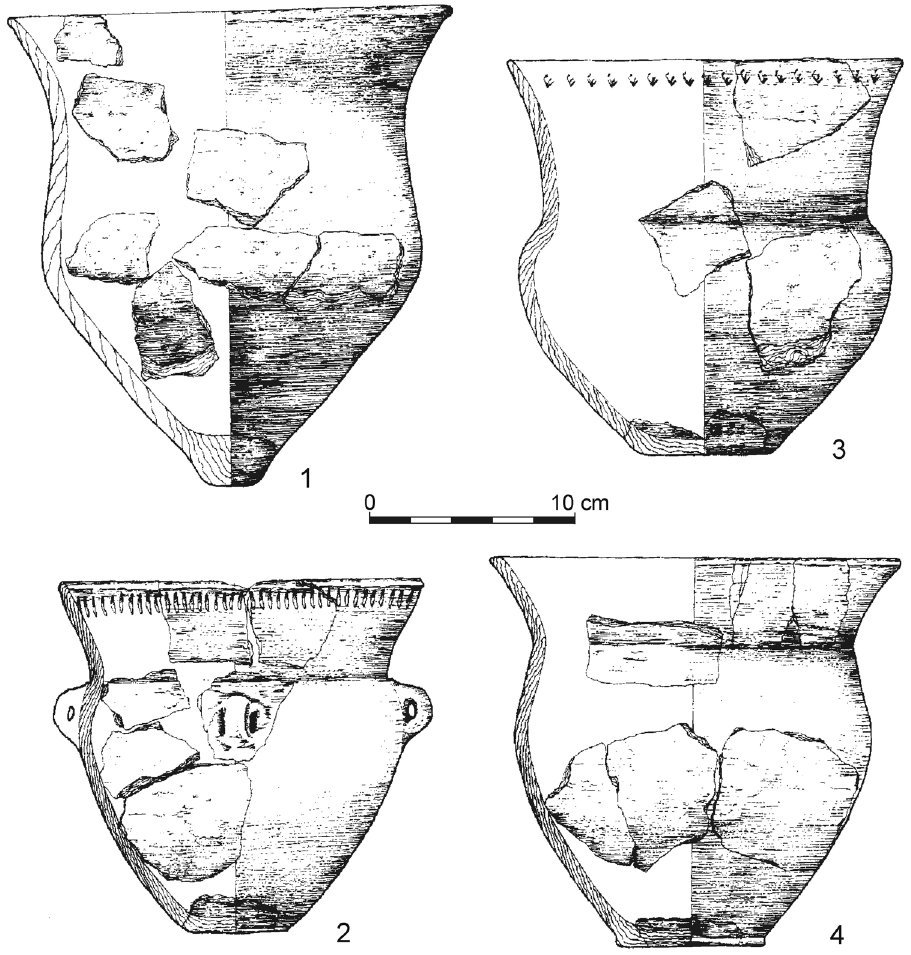
Figure 5: Pottery of the Ertebølle culture ( 1 ) and TRB ( 2 – 4 ) from the site at Tanowo ( after Gali ń ski, 2005 )